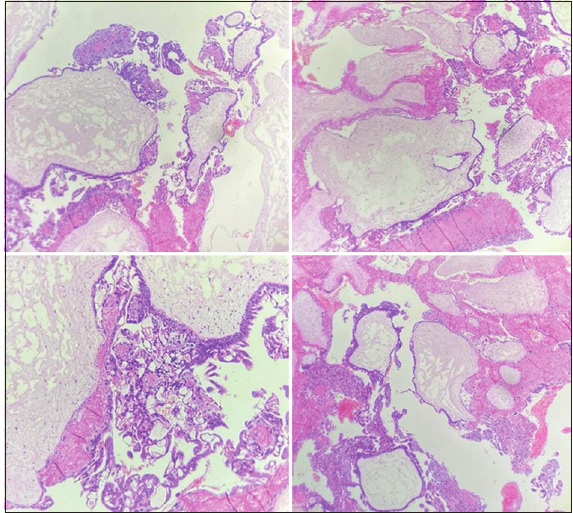
FIGURE 4. Chorionic villi with intracellular fibrin deposits and foci of fibri - noid necrosis in the vessel wall; likewise, cistern formations with hydropic changes and peripheral trophoblastic hyperplasia in relation to hydatidiform mole.